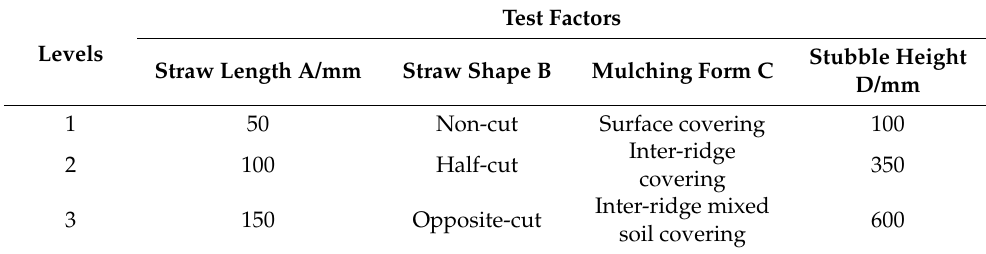
Figure 1. Sketch of level expression of test factors. Table 1. Table of test factor levels for the influence of corn straw morphological combinations on soil temperature and